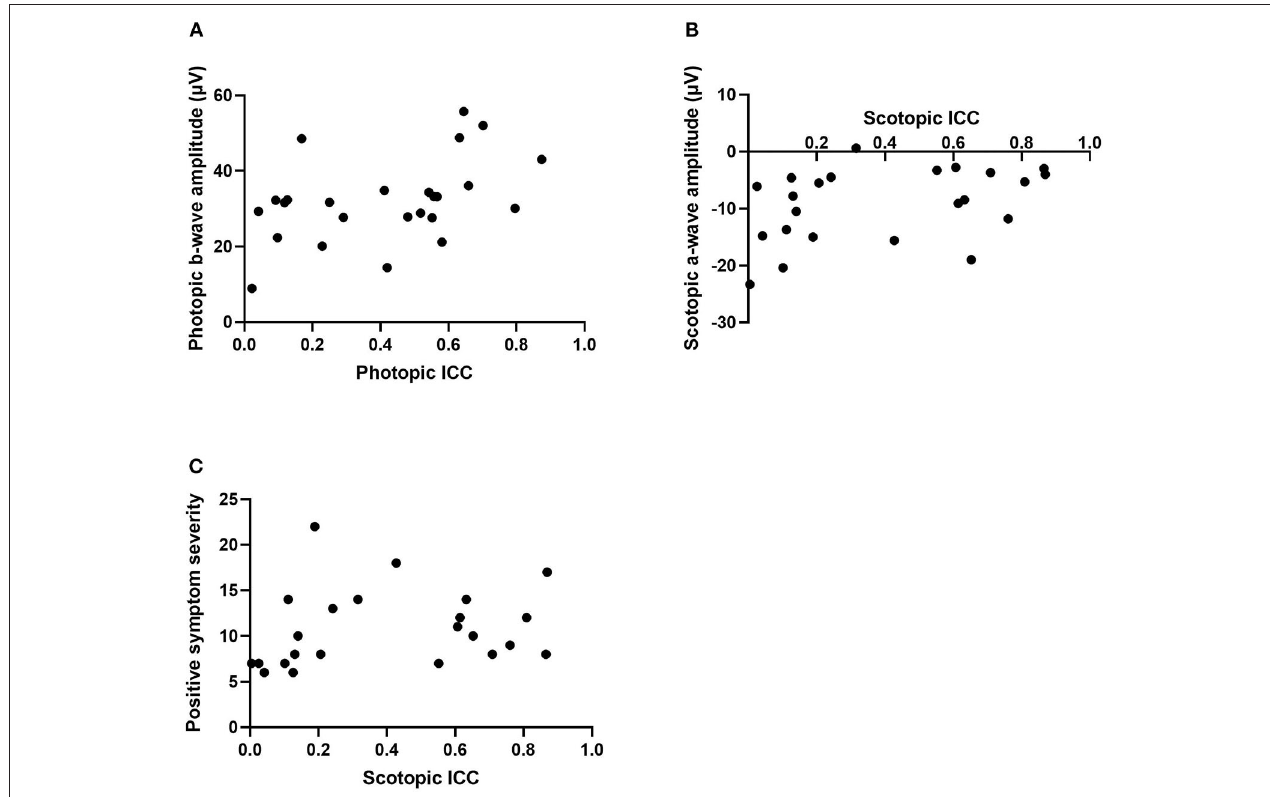
FIGURE 2 | Scatterplots representing the relationship between intra-individual variability (ICC) and photopic b-wave amplitude in microvolts (A) , scotopic a-wave amplitude in microvolts (B) , and positive symptom severity within the scotopic condition (C) . ICC, intraclass correlation coefficient.